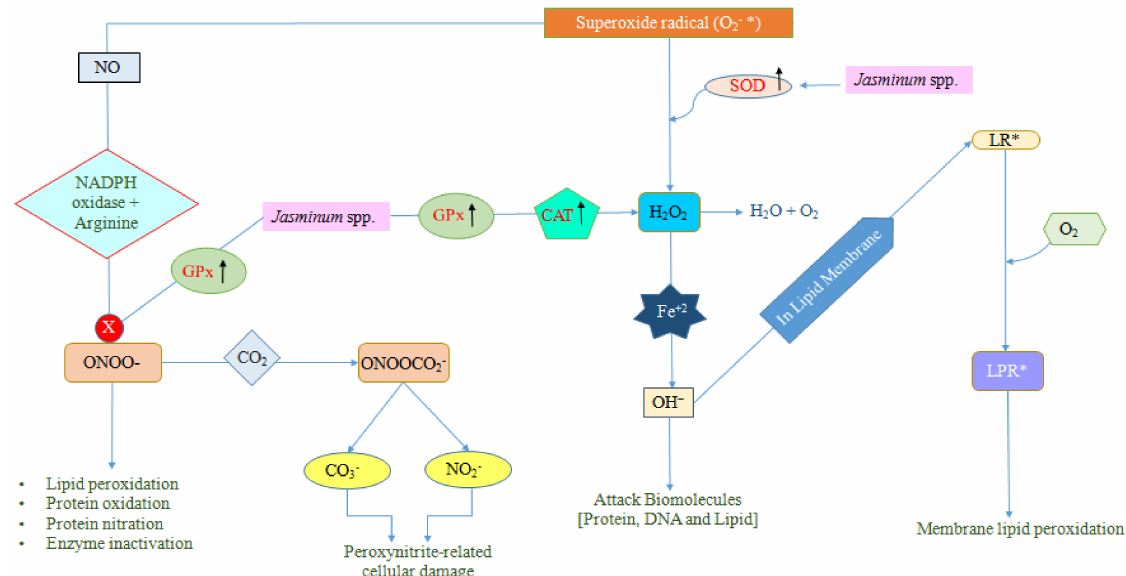
Figure 5. First line anti-oxidant defense mechanism mediated by Jasminum spp. to neutralize free radicals. Glutathione Peroxidase (GPx); catalase (CAT); Hydrogen peroxide (H 2 O 2 ); Lipid Radical (LR*); Water (H 2 O); Oxygen (O 2 ); Superoxide Dismutase (SOD); Lipid Peroxide radical (LPR*); Hydroxy radical (OH − ); Fenton reaction (Fe +2 ); Nitric Oxide (NO); Carbon dioxide (CO 2 ); Nicotinamide adenine dinucleotide phosphate oxidase (NADPH oxidase); Nitrosoperoxycarbonate (ONOOCO 2 − ); Peroxynitrate (ONOO − ); Carbonate (CO 3 − ); Nitrogen dioxide radical (NO 2 −